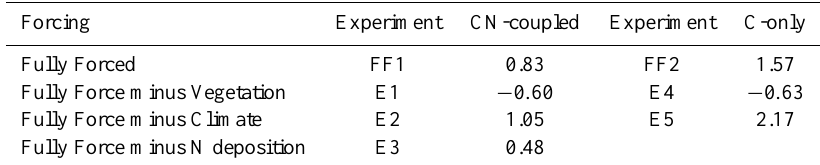
Table 8. Global NEP (PgCa − 1 ) values for the 1990s. Forcing